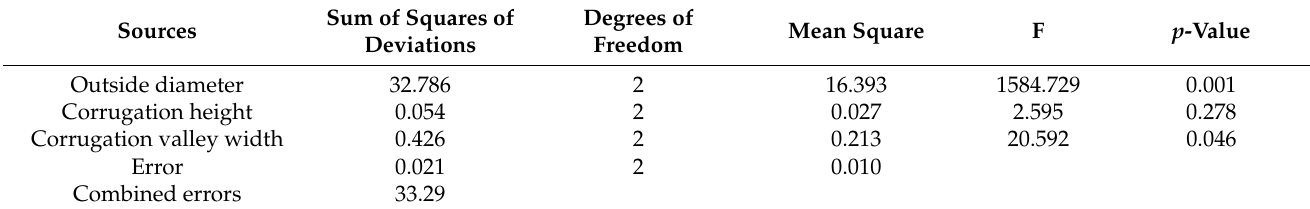
Table 7. ANOVA of the volume flow rate of the